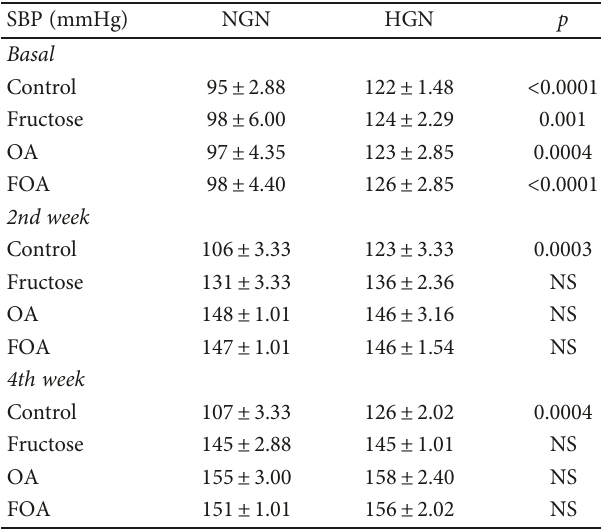
Table 3: Systolic blood pressure (SBP). Comparative e ff ect of the gonadal state at di ff erent stages of treatments.